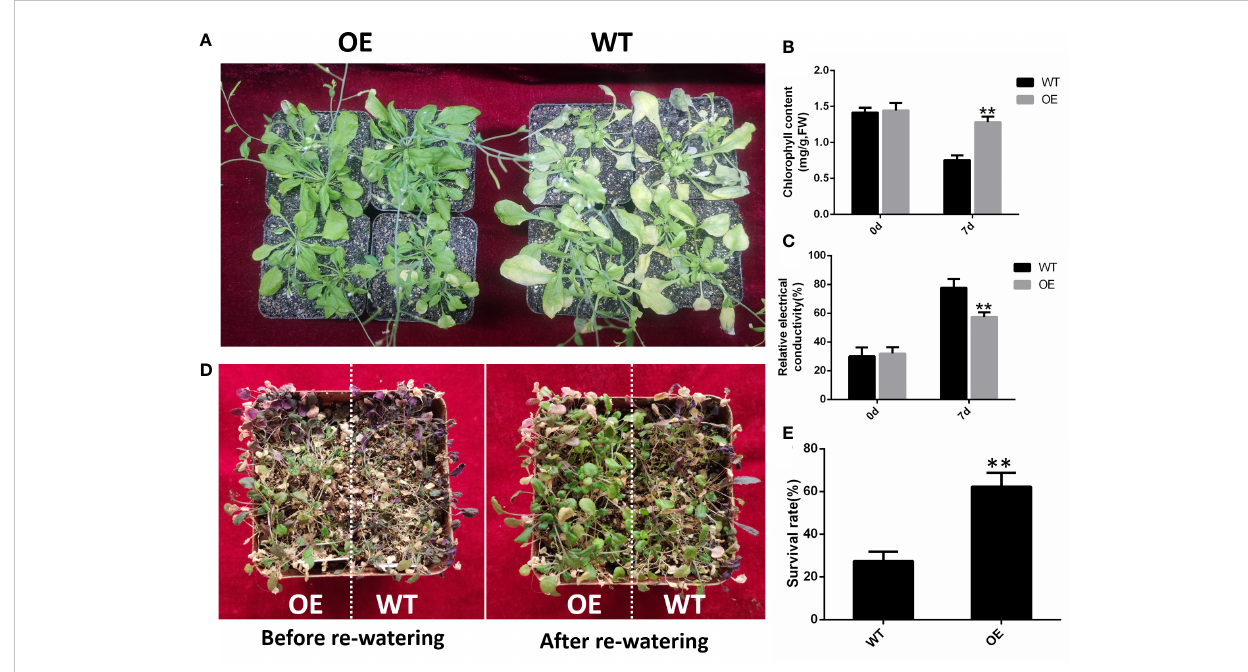
FIGURE 8 The overexpression of GhHVA22E1D increased salt tolerance and drought resistance of Arabidopsis thaliana . (A) Phenotype of Arabidopsis plants after 7 days of watering with 200 mM NaCl solution. (B) Total chlorophyll content in Arabidopsis leaves after 0 and 7 days of salt stress. (C) Relative electrical conductivity of Arabidopsis leaves after 0 and 7 days of salt stress. (D) Phenotype of Arabidopsis after 7 days of natural drought and 2 days of re-watering. (E) Survival rate of Arabidopsis after 2 days of re-watering. Results are from three replicate experiments. Signi fi cant differences are indicated by **(p < 0.01, Student t